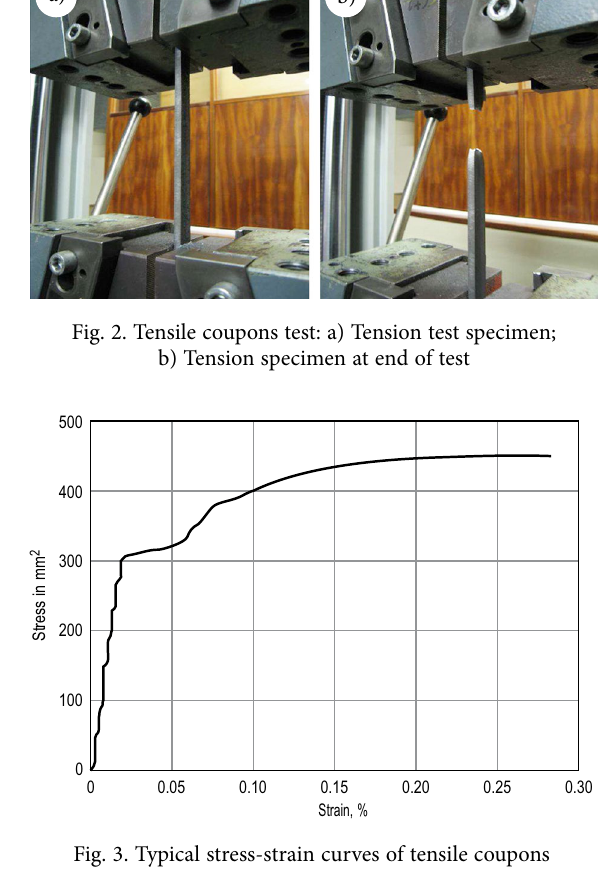
Fig. 3. Typical stress-strain curves of tensile coupons